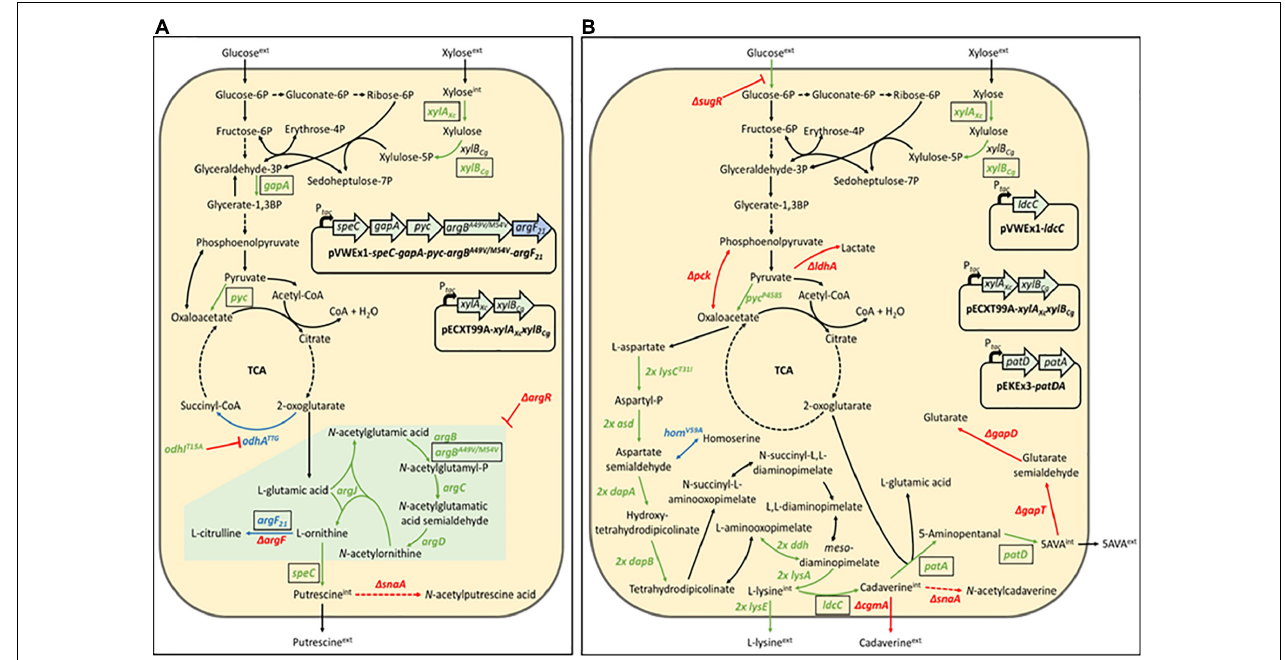
FIGURE 1 | Schematic representation of the putrescine production route in Corynebacterium glutamicum PUT Xyl (A) and the 5-aminovalerate production route in C. glutamicum AVA Xyl (B) . Gene names of key enzymes are given next to the corresponding reaction (pointed arrows). Black-boxed gene names indicate plasmid-borne expression, unboxed gene names indicate genomic expression. Reaction routes involving more than one gene are depicted by dashed arrows. Repression is represented by blunt arrows. Upregulated reactions are shown in green, downregulated reactions are shown in blue, and deleted reactions are shown in red. The green-boxed arginine pathway in (A) indicate upregulation by deletion of the repressor of the arginine biosynthesis ArgR . argB A 49 V / M 54 V , feedback-resistant N-acetyl glutamate kinase; argF , ornithine transcarbamoylase; argF 2 1 , ornithine transcarbamoylase with reduced activity; argR , repressor of the arginine biosynthesis; asd (2 copies), aspartate-semialdehyde dehydrogenase; cgmA , cyclic beta-1,2-glucan modification protein; dapA (2 copies), 4-hydroxy-tetrahydrodipicolinate synthase; dapB (2 copies), 4-hydroxy-tetrahydrodipicolinate reductase; ddh (2 copies), meso-diaminopimelate D-dehydrogenase; gabD , succinate-semialdehyde dehydrogenase; gabT , 4-aminobutyrate aminotransferase; gapA , Glyceraldehyde-3-phosphate dehydrogenase A; hom V 59 A , reduced activity homoserine dehydrogenase; ldcC , constitutive lysine decarboxylase; ldhA , D-lactate dehydrogenase; lysA (2 copies), diaminopimelate decarboxylase; lysC T 311 I (2 copies), high activity aspartokinase; lysE (2 copies), lysine exporter; odhA TTG , reduced activity 2-oxoglutarate dehydrogenase; odhI T 15 A , high activity oxoglutarate dehydrogenase inhibitor; patA , putrescine aminotransferase; patD , gamma-aminobutyraldehyde dehydrogenase; pck , phosphoenolpyruvate carboxykinase; P tac , IPTG-inducible tac promoter; pyc , pyruvate carboxylase; pyc P 458 S , high activity pyruvate carboxylase; snaA , N-acetyltransferase; speC , ornithine decarboxylase; sugR , central transcriptional regulator of the carbon metabolism; xylA Xc , xylose isomerase from Xanthomonas campestris ; xylB Cg , xylulose kinase from C.